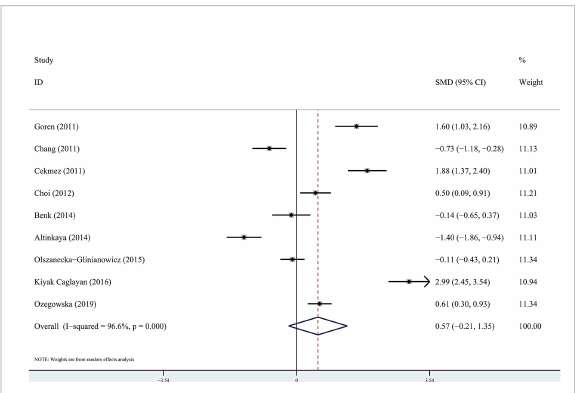
FIGURE 3 Forest plots of circulating chemerin levels in patients with polycystic ovary syndrome compared with controls. Diamond represents the pooled odds ratio at 95% con fi dence